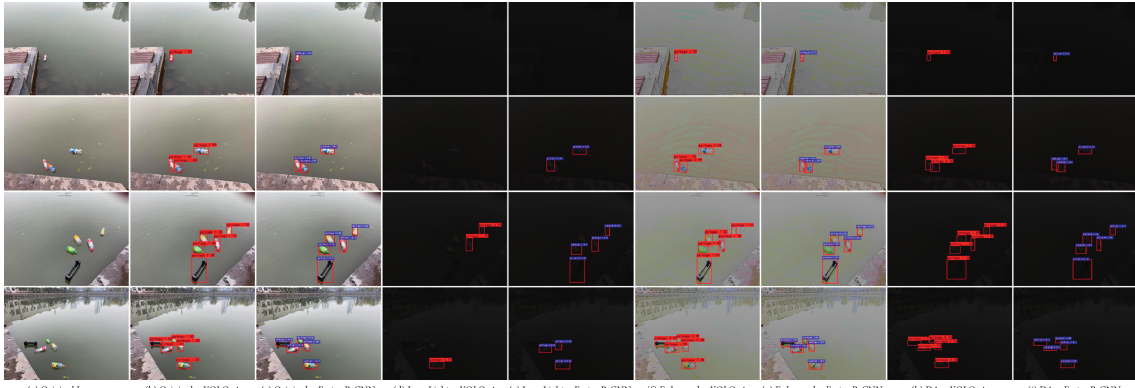
Figure 8: The water-surface garbage detection results under low-light conditions. From left to right: (a) original sharp images, original dataset-trained YOLOv4, and Faster R-CNN for detection results from (b-c) sharp images, (d-e) synthetic low-light images, (f-g) enhanced images, augmented dataset-trained YOLOv4, and Faster R-CNN for detection results from (h-i) synthetic low-light images, respectively. (a) Original images. (b) Original+YOLOv4. (c) Original+Faster R-CNN. (d) Low-light +YOLOv4. (e) Low-light +Faster R-CNN. (f) Table 3: The influences of low-light imaging condition and visibility enhancement on water-surface garbage detection. Detection methods